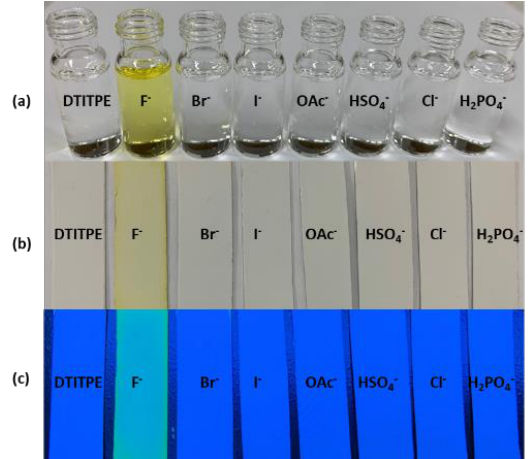
Figure 8. Color change of 1 × 10 −5 M of DTITPE in the presence of various anions ( a ) in THF solution, and on silica gel strips under ( b ) ambient light and ( c ) UV irradiation (254 nm).